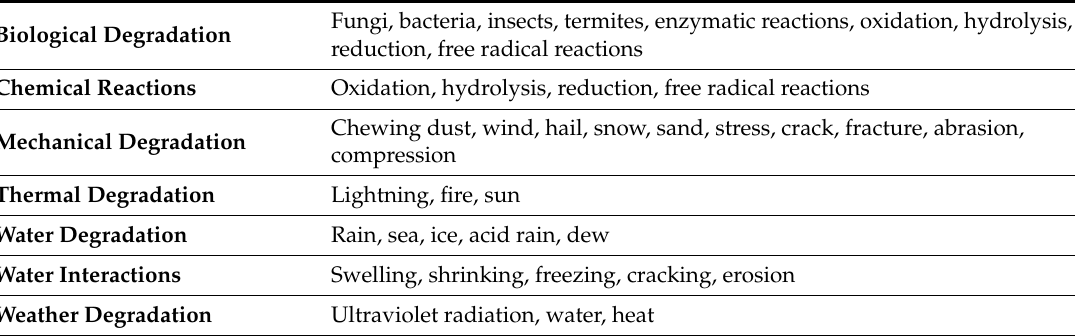
Table 1. Major degradation pathways and